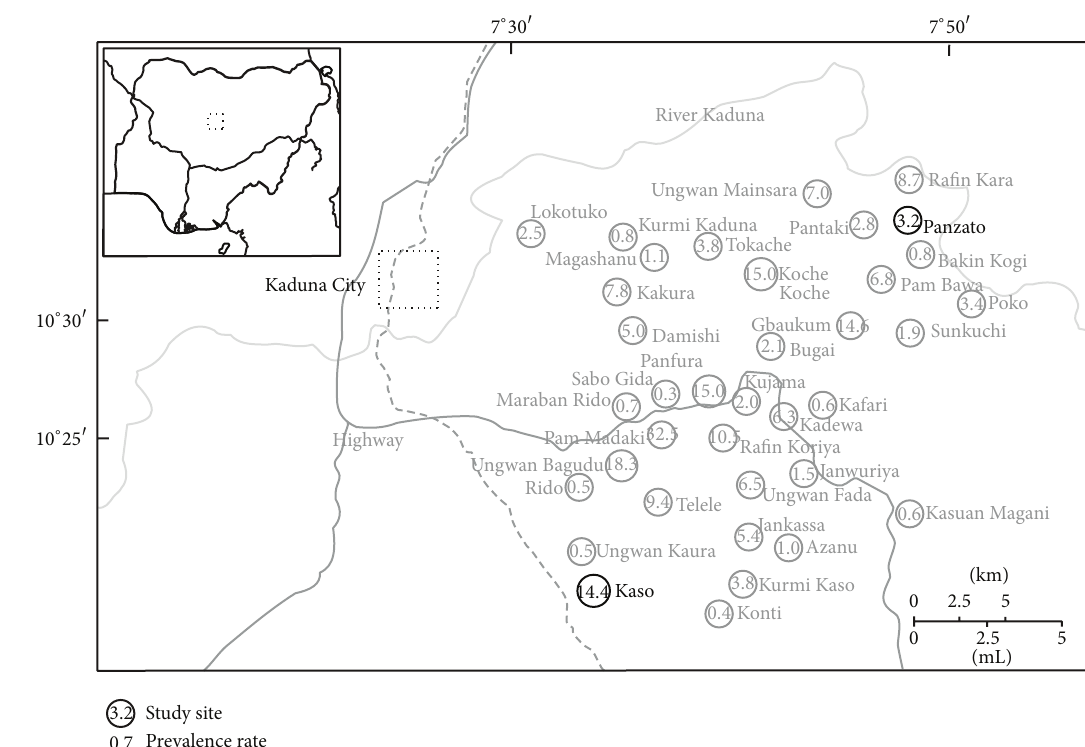
Figure 1: Study area and study